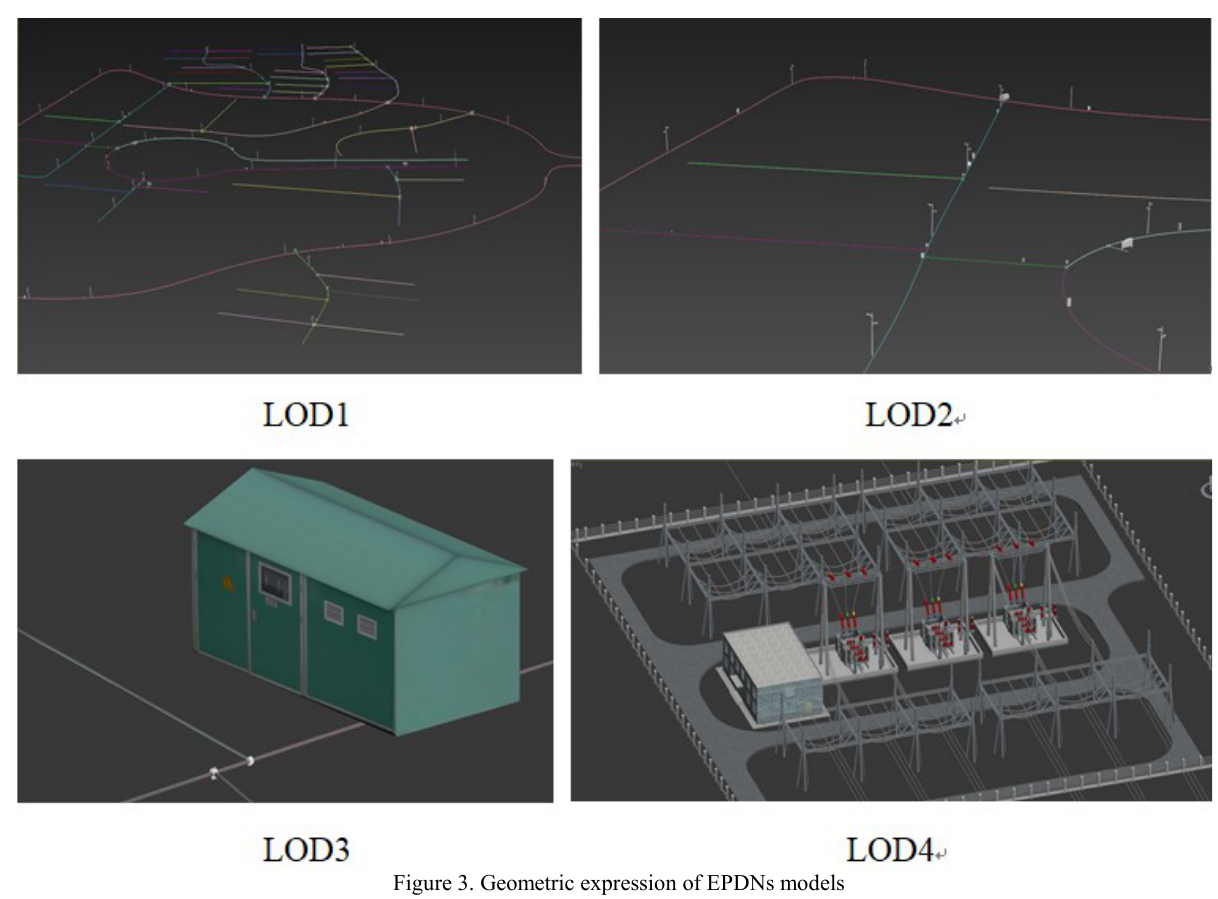
Figure 3. Geometric expression of EPDNs